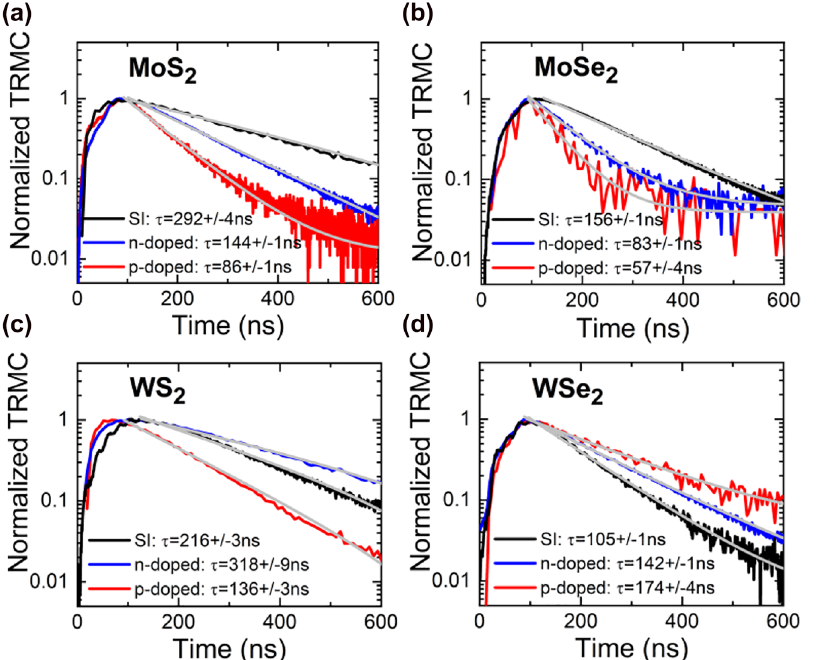
Figure 4: Normalized transient signal of nominally undoped (semi-insulating, SI) (black curves), n -doped (blue curves) and p -doped (red curves) TMDs obtained at room temperature. The gray lines represent the fi ts with single exponential